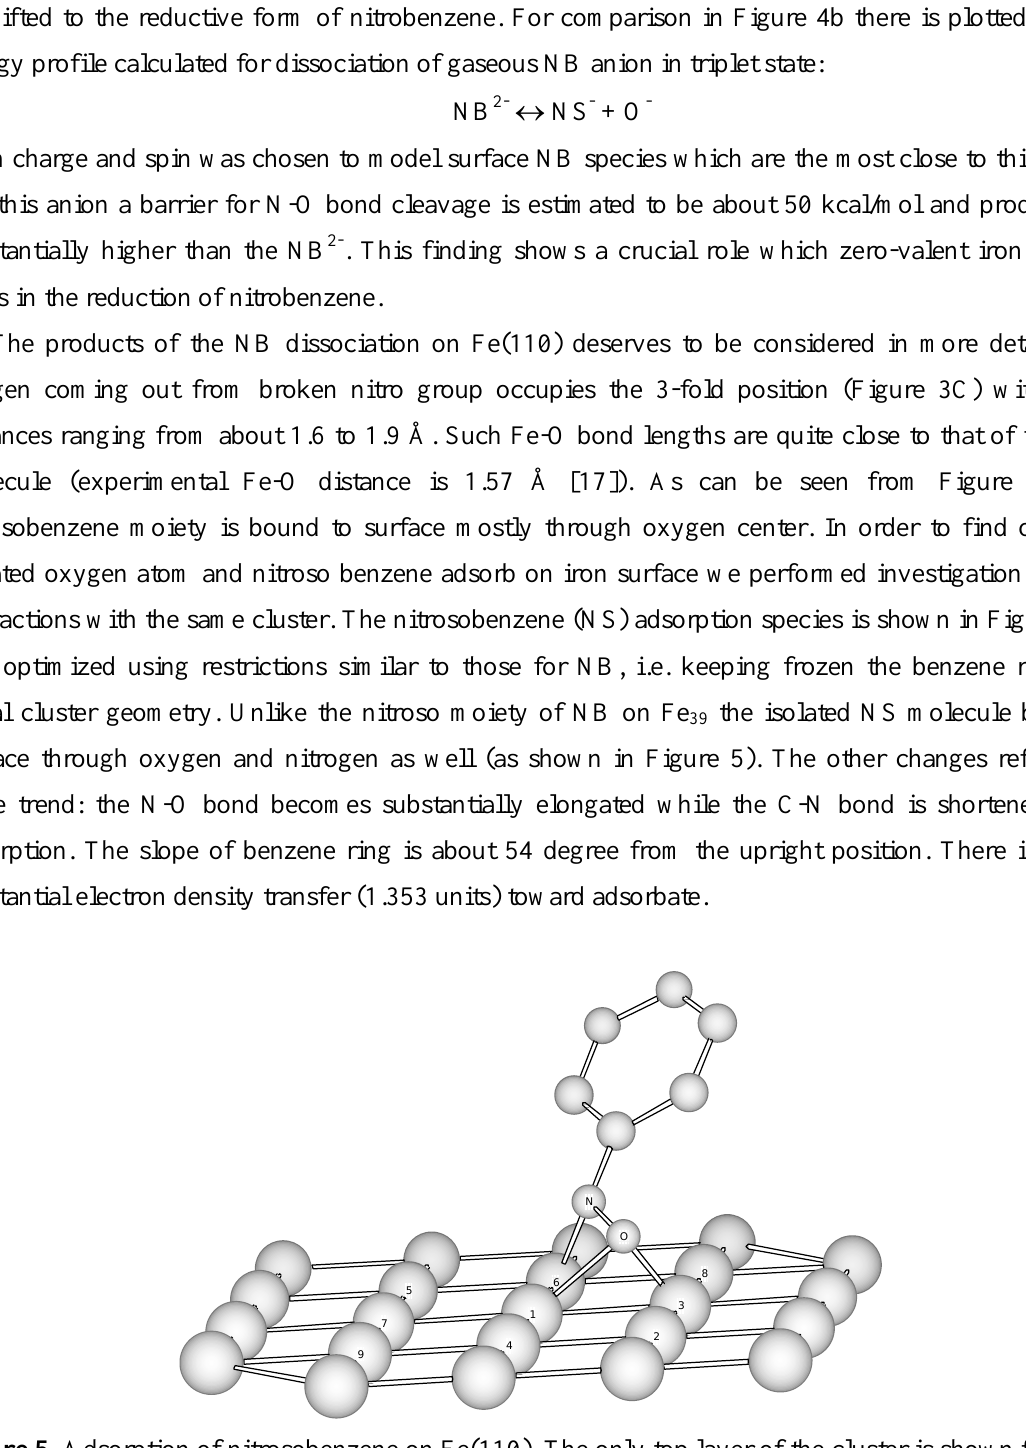
Figure 5. Adsorption of nitrosobenzene on Fe(110). The only top layer of the cluster is shown for simplicity. Calculated distances (Å) and valence angles (degrees): N-C 1.350, N-O 1.506, N-Fe1 2.314, N-Fe3 2.356, N-Fe6 2.004, O-Fe1 1.994, O-Fe2 2.441, O-Fe3 1.625, O-N-C